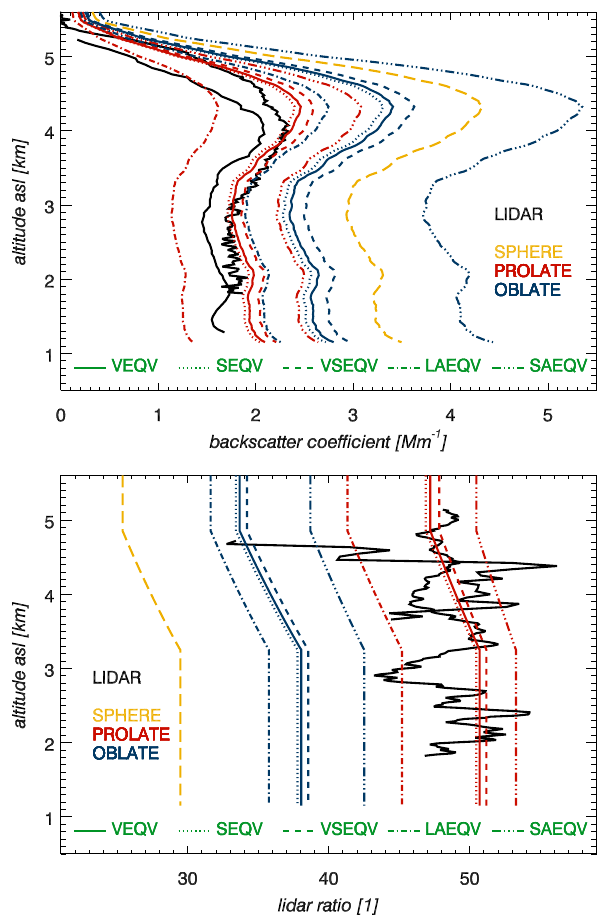
Fig. 9. The same as in Fig. 8, but for backscatter coefficient (top) and lidar ratio (bottom) at 532nm compared to lidar data (black) as measured on 19 May 2006 over OZT site about noon (Sect. 2).